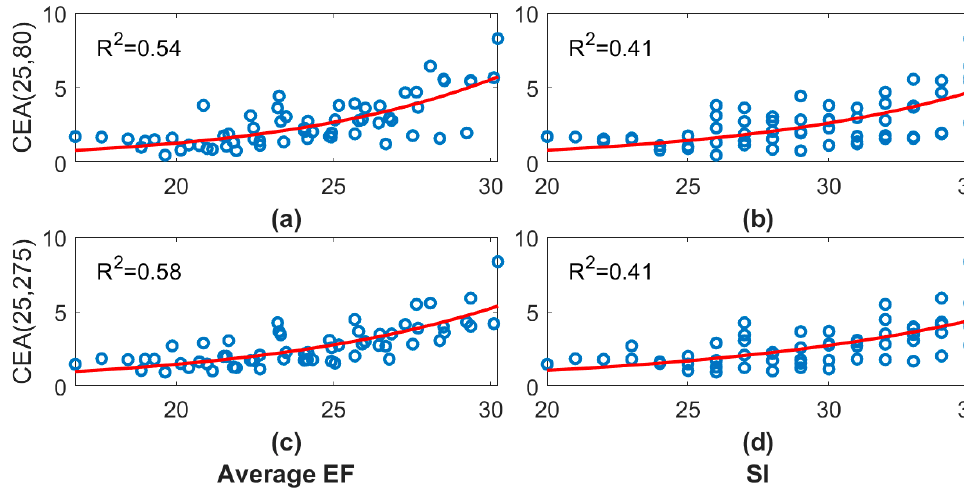
Figure 7. Exponential model fits for the CEA(25,80) measure across all subjects vs. ( a ) the average E-field and ( b ) the stimulation intensity. ( c , d ) are the same as ( a , b ), but for CEA(25,275). The adjusted R 2 for each model fit is shown inside each panel.